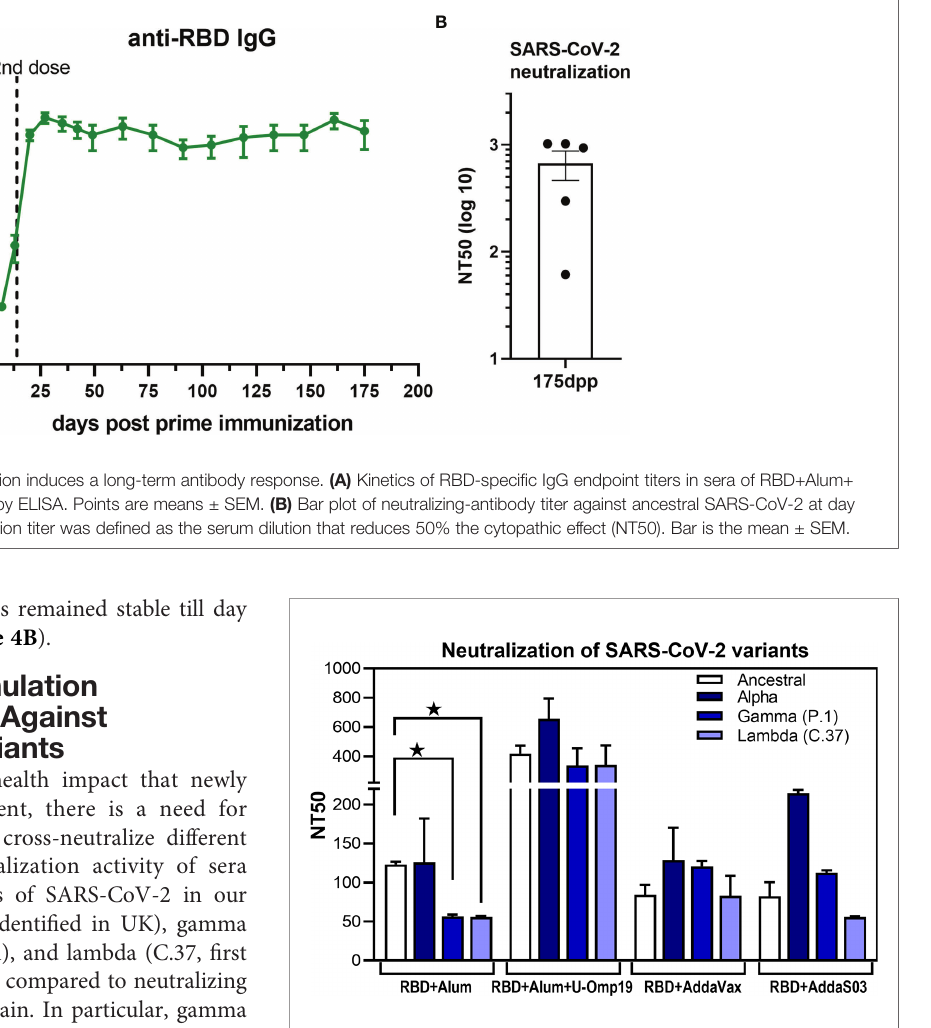
FIGURE 5 | U-Omp19+Ag+Alum formulation induces neutralizing Abs against multiple SARS-CoV-2 variants. BALB/c mice were vaccinated as described in Figure 2 . Neutralizing-antibody titers against ancestral (Wuhan reference strain) SARS-CoV-2 and alpha, gamma (P.1), and lambda (C.37) variants were assessed 30 days post second dose. Neutralization titer was de fi ned as the serum dilution that reduces 50% the cytopathic effect (NT50). Bars represent means ± SEM. *p < 0.05. One-way ANOVA with Bonferroni post-test. Results are representative of two independent